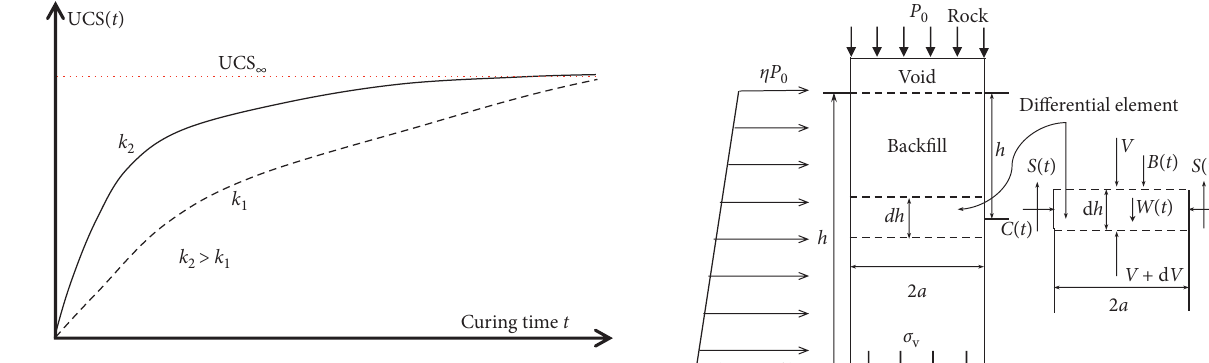
Figure 8: Curves of relationship between backfills strength and curing age.